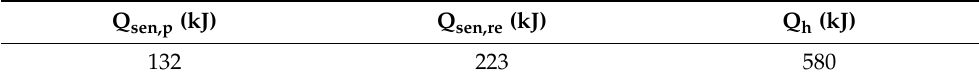
Table 7. Demand energy in the reactor.